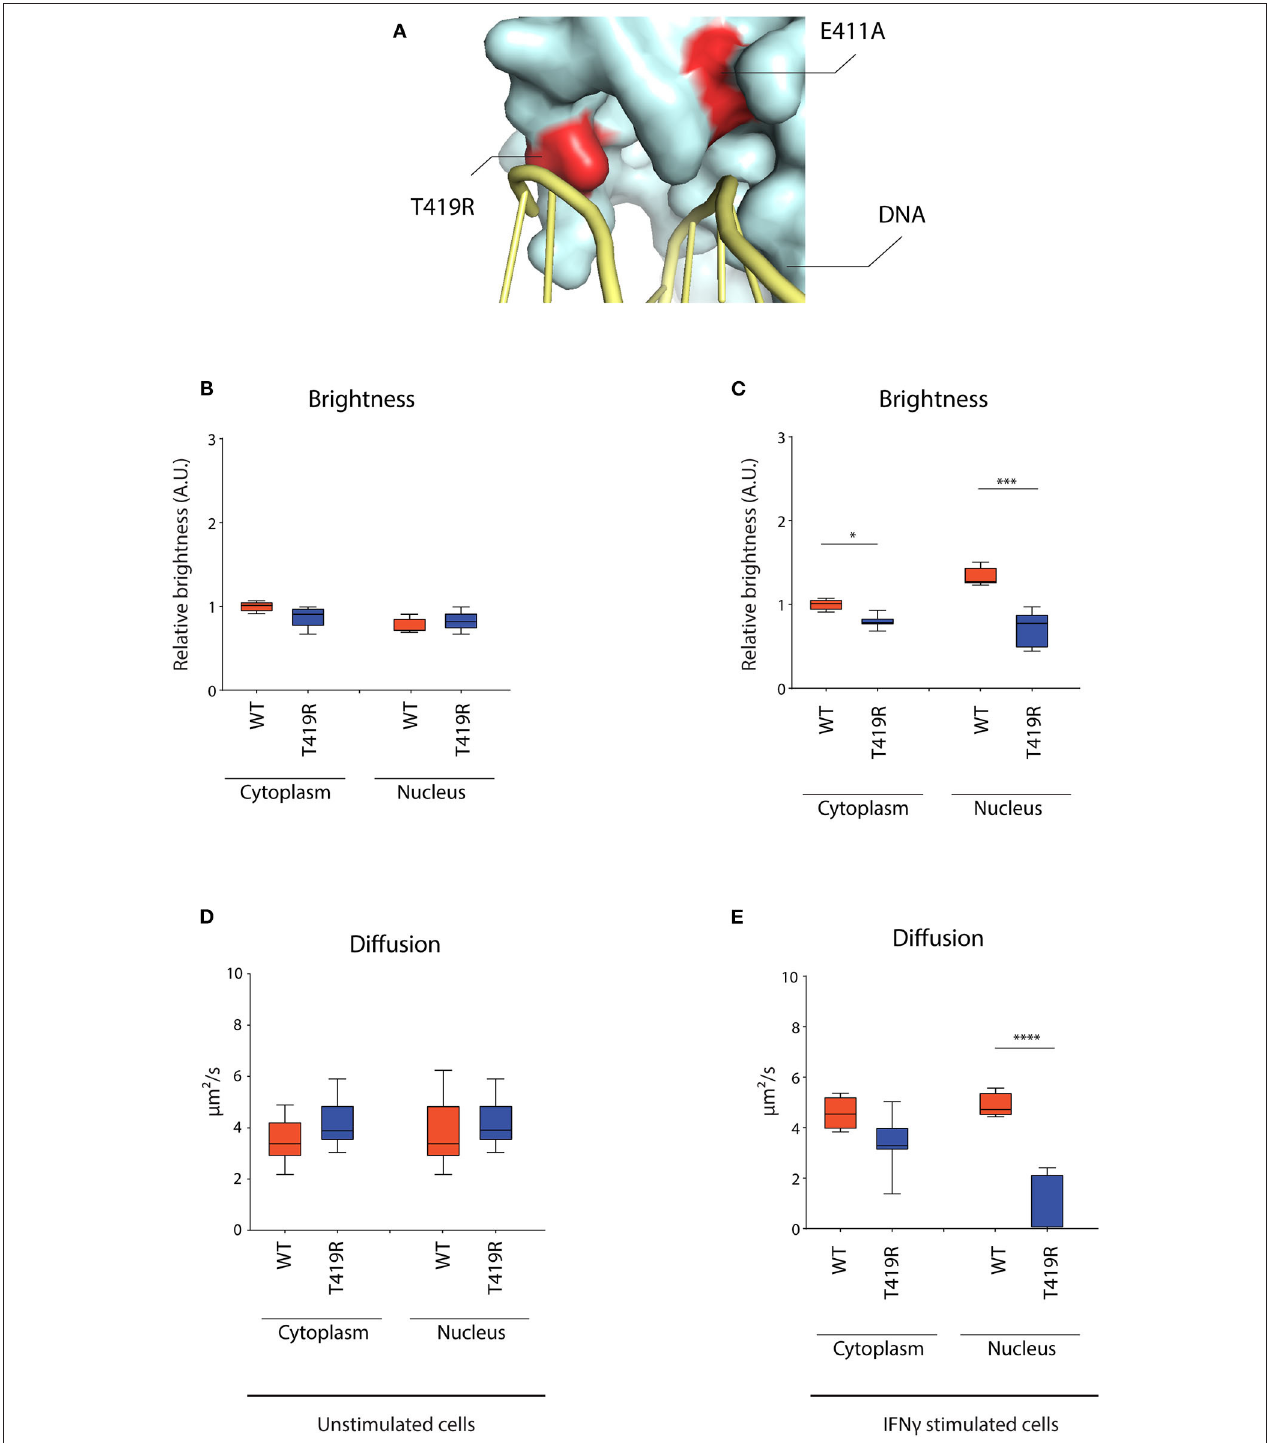
FIGURE 7 | RICS analysis of STAT1-GFP WT and T419R GOF mutant in U3A cells. (A) Detail of crystal structure of STAT1 bound to DNA. Highlighted in red are the T419R and the E411A mutations, situated in close proximity of the DNA. (B) Average brightness in unstimulated condition and (C) after IFN γ stimulation. (D) Average diffusion constant in unstimulated condition and (E) after IFN γ stimulation. Data in panels (B–E) ( n > 7) are represented in box and whiskers plot. The central line represents the median, while the box extends from the 25th to 75th percentiles with whiskers spanning 10–90% intervals. Dots outside these intervals are represented as single dots. Statistical analysis: One-way ANOVA with Tukey’s post-hoc test. * P < 0.05 ; *** P < 0.001 ; **** P < 0.0001.